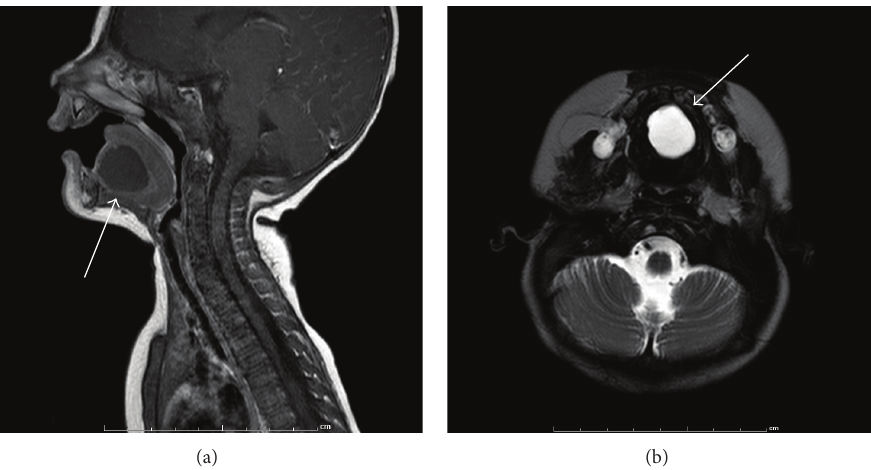
Figure 1: MRI. (a) T1-weighted, sagittal view: nonenhancing cystic mass in the sublingual space (arrow) without involvement of sublingual or submandibular glands. (b) T2-weighted, axial view: hyperintense mass midline in the anterior lower oral cavity (arrow).